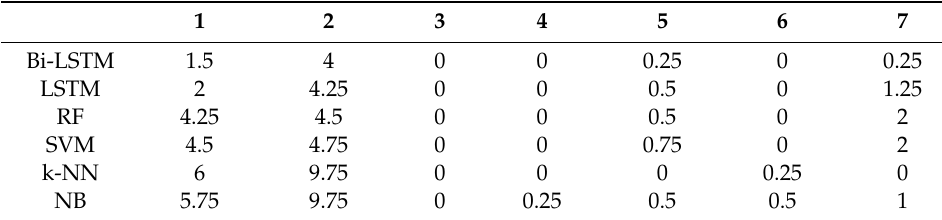
Table 4. Representation of omission errors for every class.